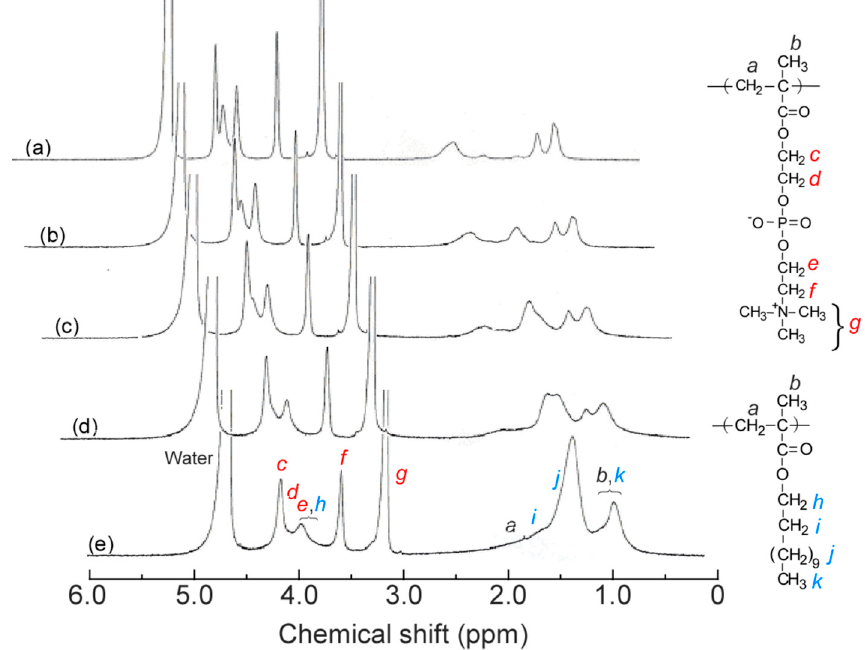
Figure 3. 1 H NMR spectra for P(MPC/DMA x ) in D 2 O containing 0.1 M NaCl: x = 0 ( a ), 10 ( b ), 19 ( c ), 28 28 ( d ), and 38 mol % ( e ( d ), and 38 mol % ( e ).